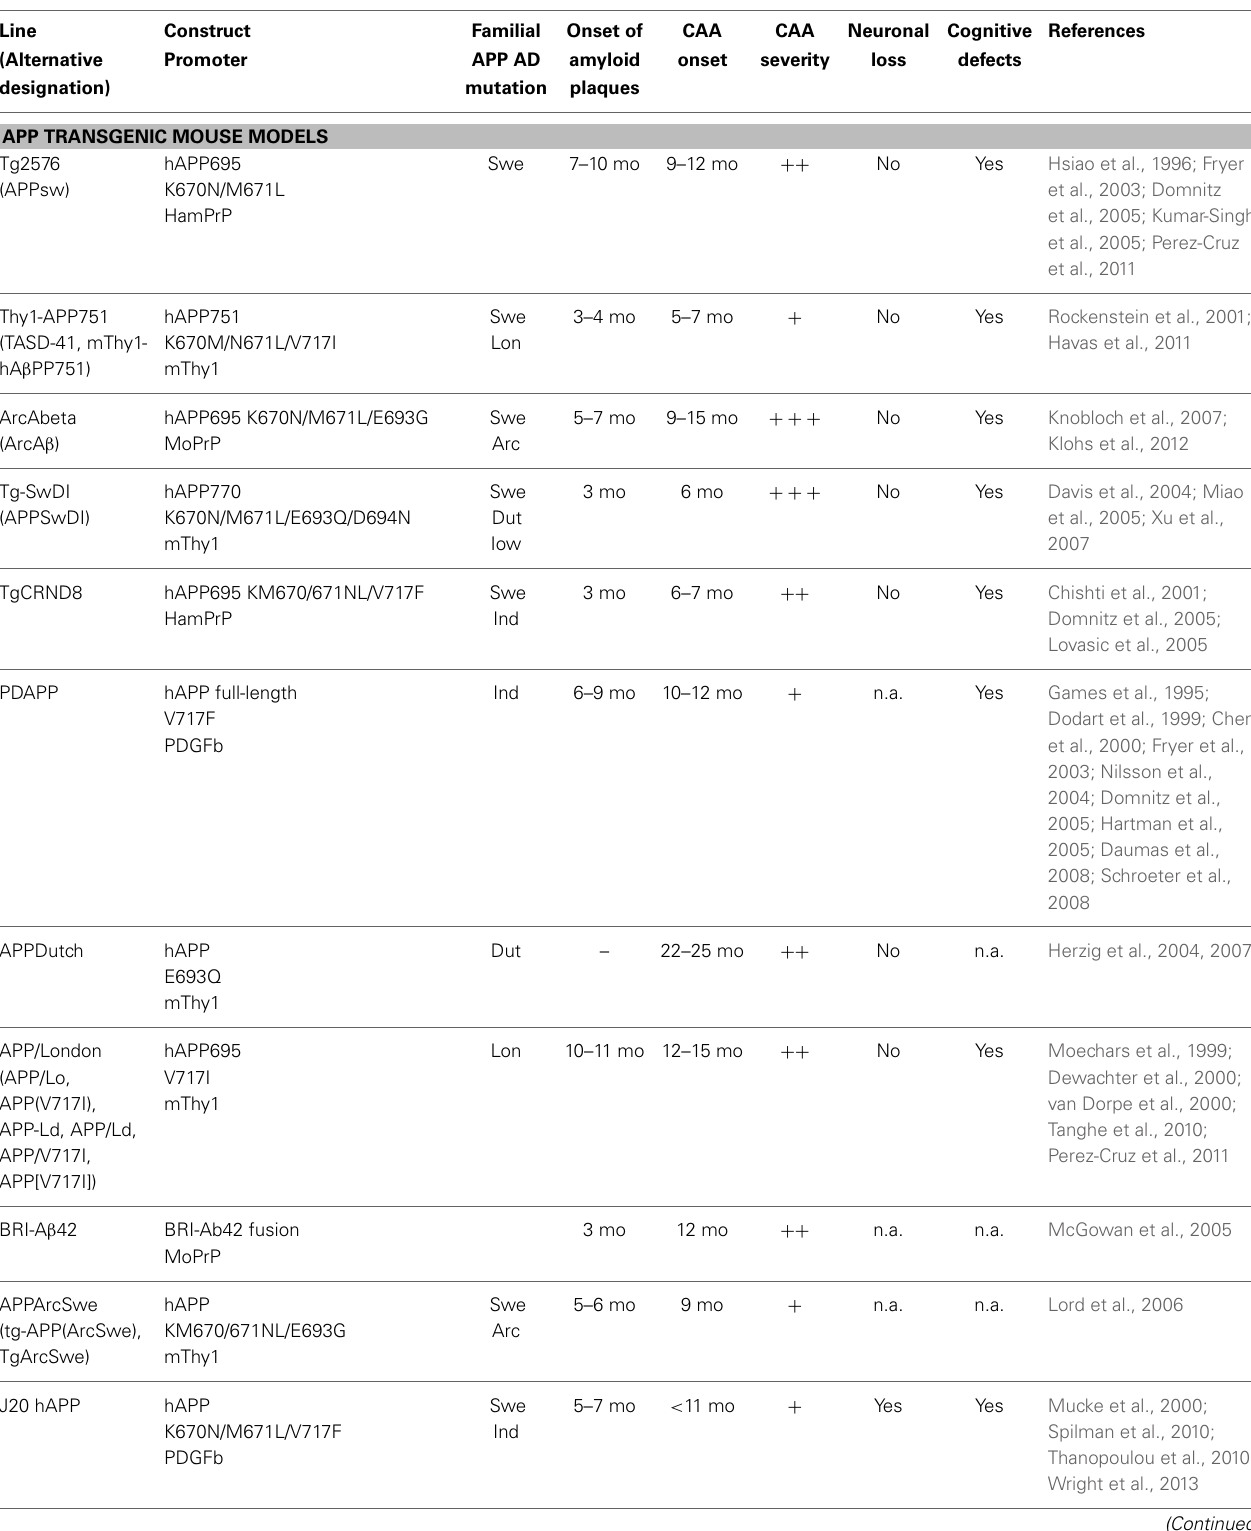
Table 1 | Summary of transgenic models used in AD research and their relation to CAA